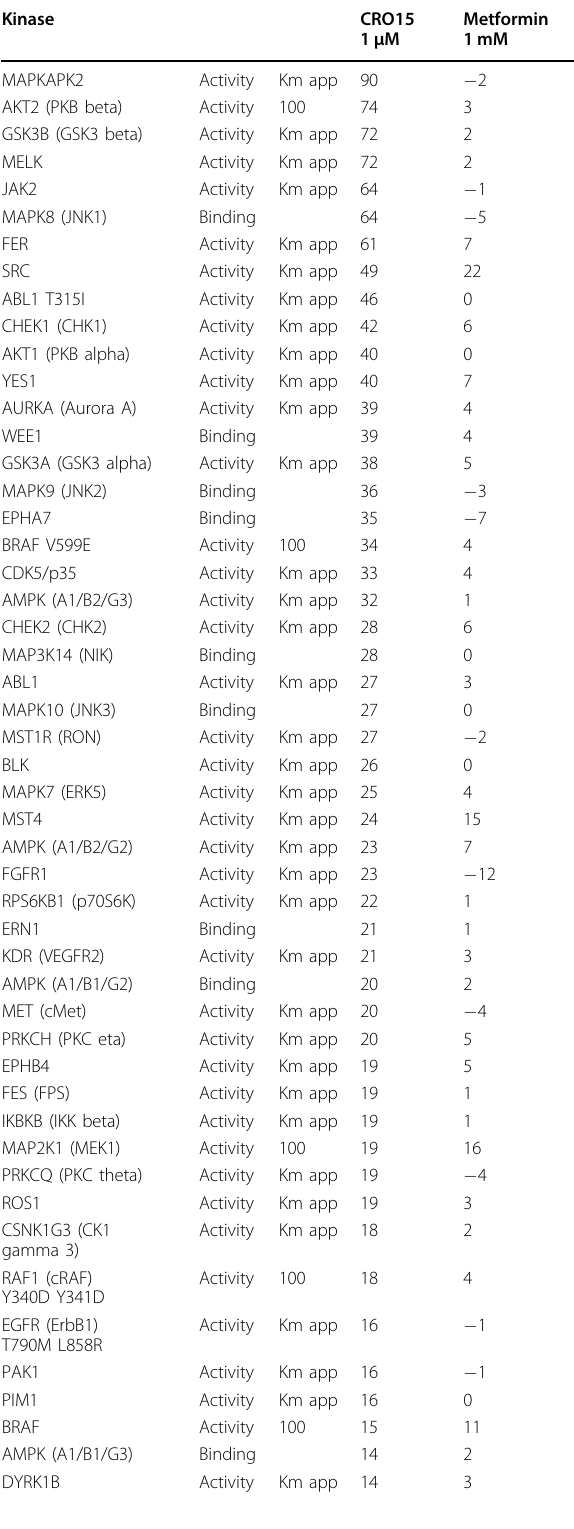
Table 1 Results of in vitro Kinome assay in response